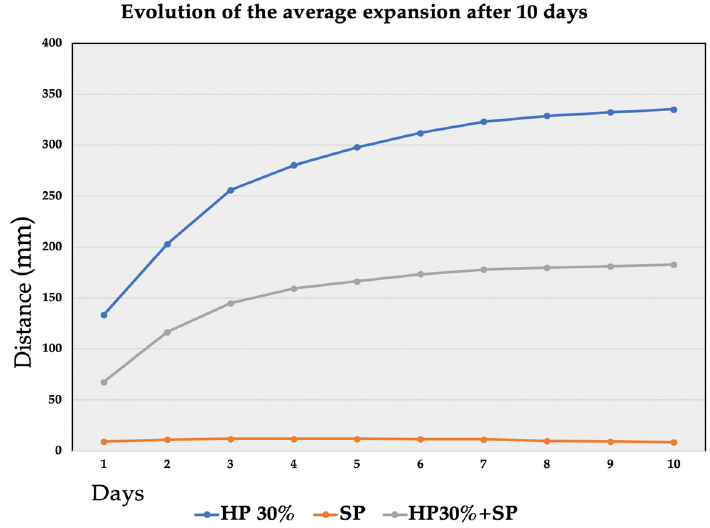
Figure 2. Evolution of the average expansion over time for each bleaching agent at 10 days.